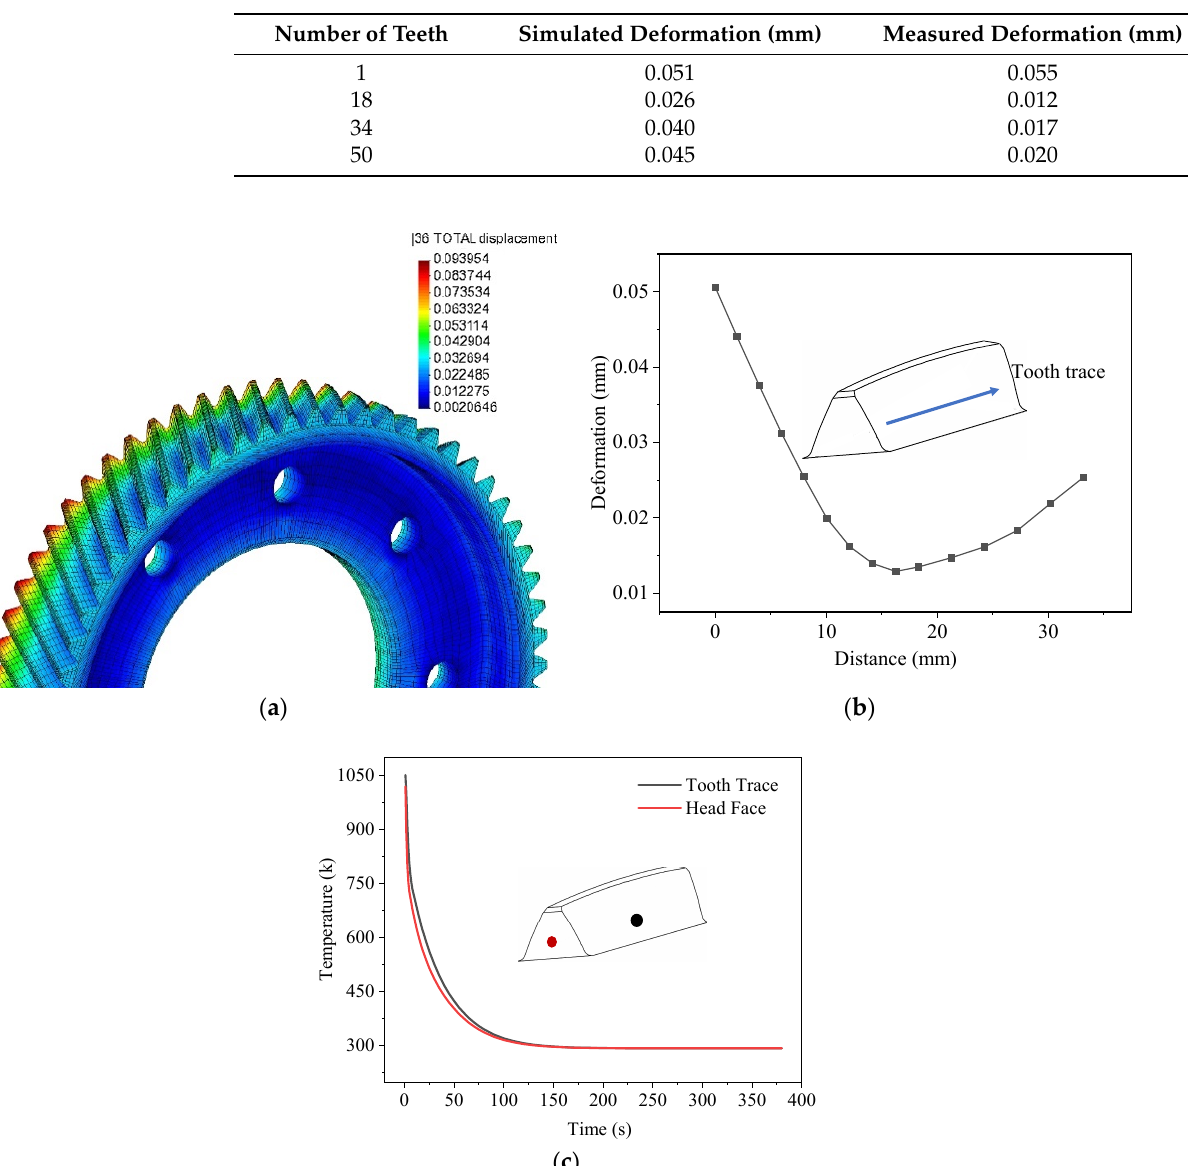
Figure 10. ( a ) Deformation distribution cloud atlas after carburizing and quenching; ( b ) simulation value of surface deformation; and ( c ) temperature evolution of the surface.